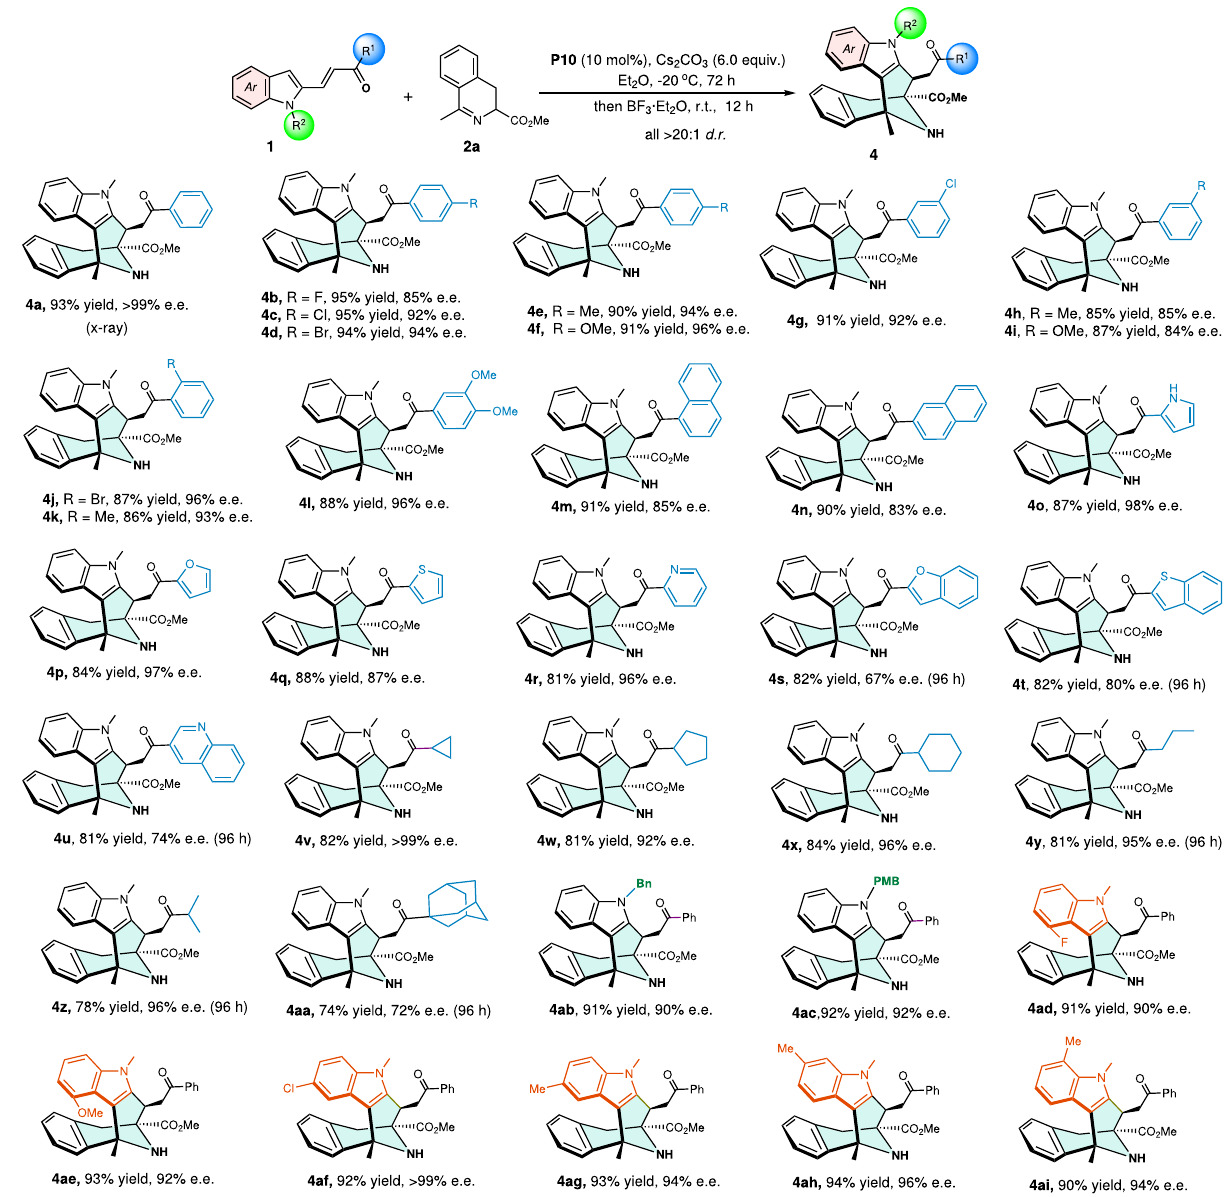
Fig. 4 Scope with respect to 2-vinylindoles. Unless other noticed, reactions were performed with 1 (0.10 mmol), 2a (0.12 mmol), P10 (0.01 mmol), and Cs 2 CO 3 (0.60 mmol) in Et 2 O (2.0 mL) at − 20 °C for 72 h; then BF 3 ·Et 2 O (1.0 mmol) was directly added to the reaction mixture which was further stirred